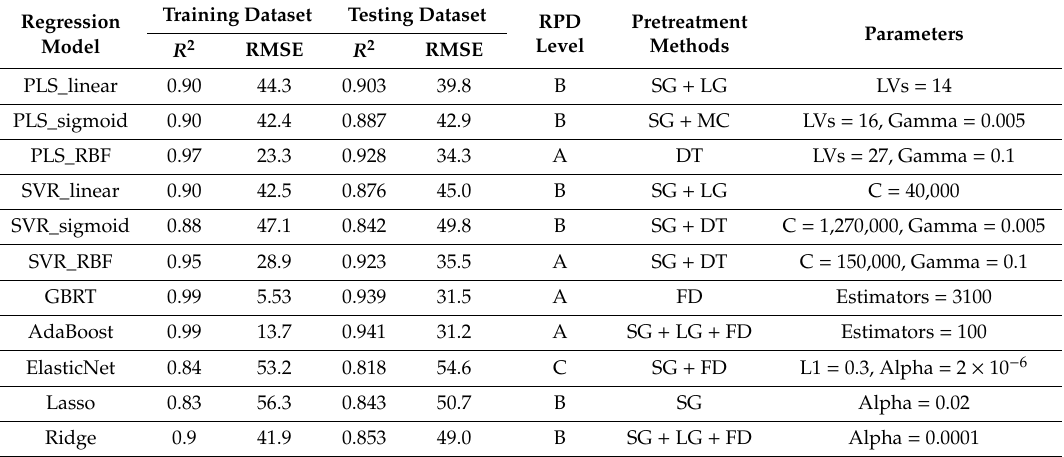
Table 6. The performance and parameters of the best regression models.